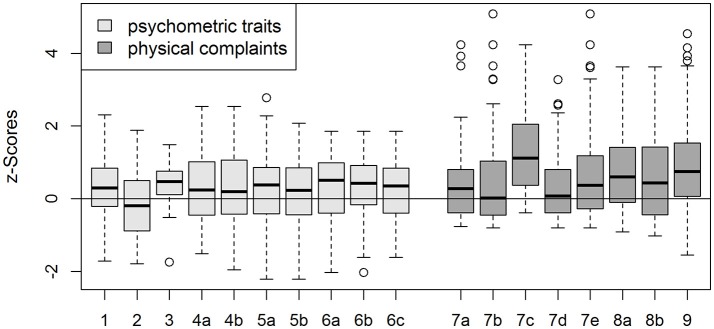
Z scores (mean/median) for different neuropsychological traits and physical complaints, which differed from controls in an age- and gender- independent comparison, with respect to disease- and treatment associated factors as well as comorbidities. Z-score formation implies that values of age- and sex-matched controls would be 0 in mean/median. 1—agreeable in patients on chronic medication (Z = 0.31 ± 0.90); 2—cold/denying in patients with pituitary insufficiency (Z = −0.24 ± 0.83); 3—introvert/socially avoidant in patients who received pituitary radiation (Z = 0.34 ± 0.74); 4—non-assertive/insecure in patients (a) on chronic medication (Z = 0.27 ± 0.93), (b) with arthrosis (Z = 0.25 ± 0.96); 5—exploitable/permissive in patients (a) on chronic medication (Z = 0.28 ± 0.99), (b) with arthrosis (Z score = 0.20 ± 0.88); 6—nurturant in patients with (a) active disease (Z = 0.28 ± 0.94), (b) on chronic medication (Z = 0.28 ± 0.9), (c) with arthrosis (Z = 0.26 ± 0.85); 7—gastric complaints in patients with (a) active disease (Z = 0.51 ± 1.33), (b) on chronic medication (Z = 0.51 ± 1.33), (c) with history of malignancy (Z = 1.33 ± 1.28), (d) with arthrosis (Z = 0.34 ± 0.95), (e) with pituitary insufficiency (Z = 0.77 ± 1.47); 8—heart complaints in patients (a) with active disease (Z = 0.77 ± 1.15), (b) on chronic medication (Z = 0.58 ± 1.21); 9, total GBB in patients with comorbidities overall (Z = 0.89 ± 1.27).